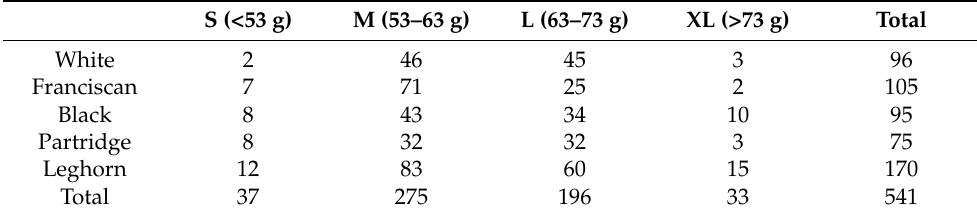
Table 2. Number of observations (eggs) classified per breed/variety and commercial